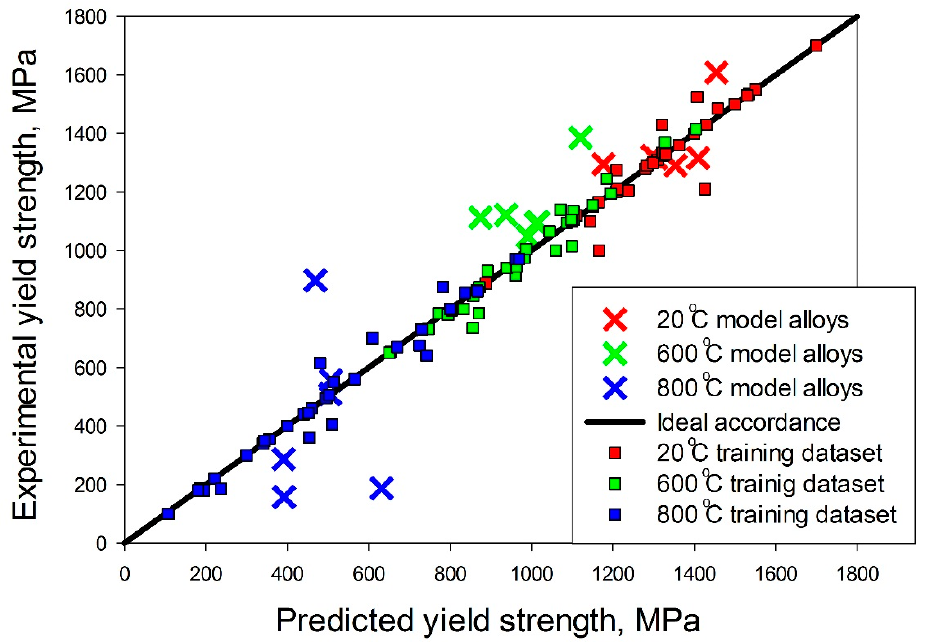
Figure 12. Predicted and experimental values of yield strength at 20 °C, 600 °C and 800 °C.